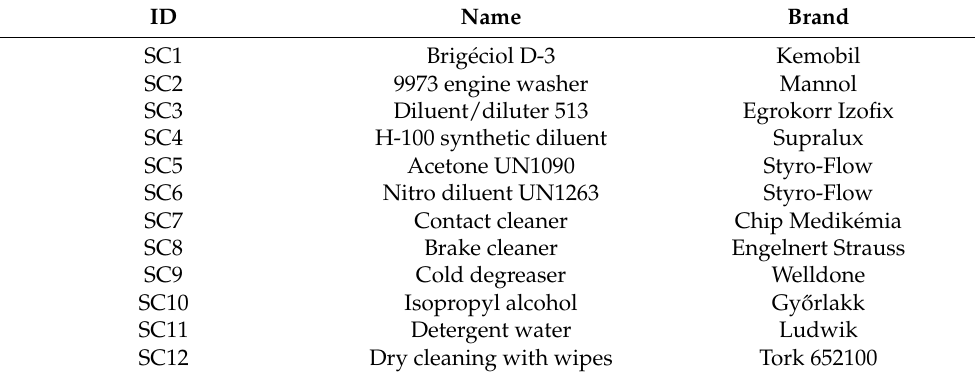
Table 1. The used surface preparation materials.